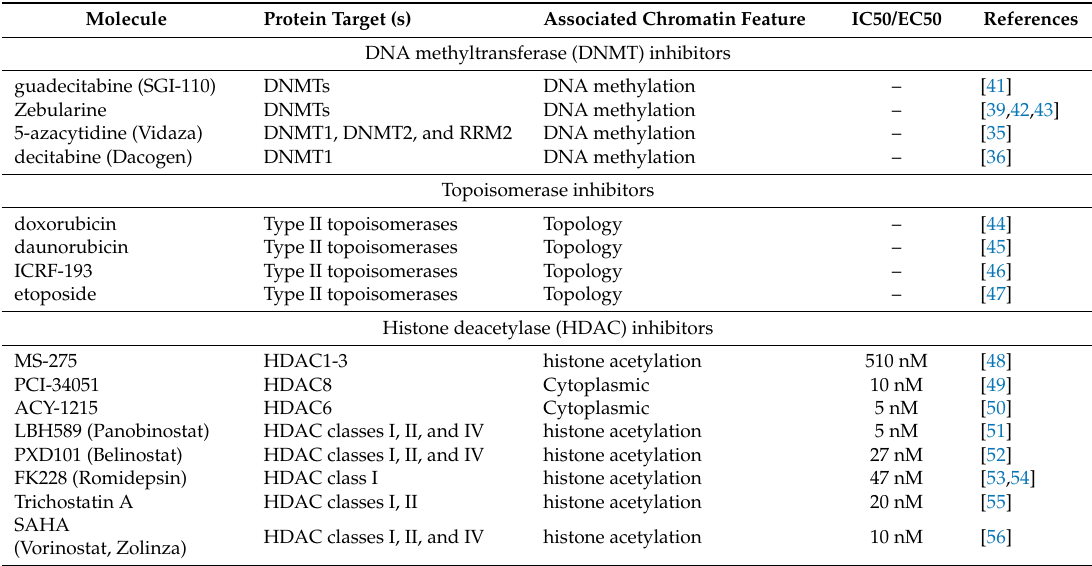
Table 1. Potent and selective drugs to inhibit chromatin